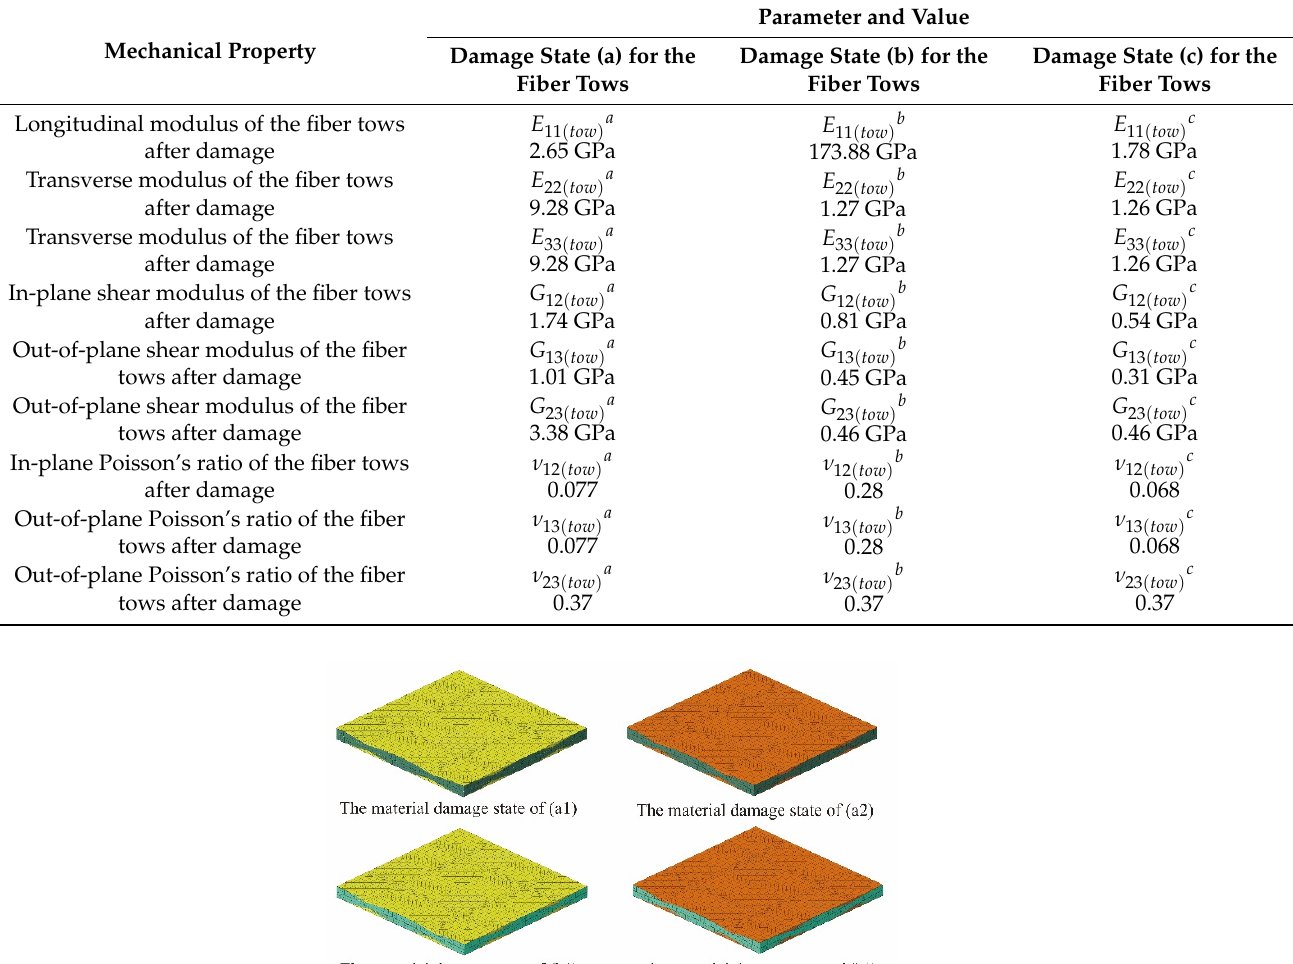
Table 13. Mechanical properties of the fiber tows in the T300/Epoxy composite after the initiation of the constituents’ damage.